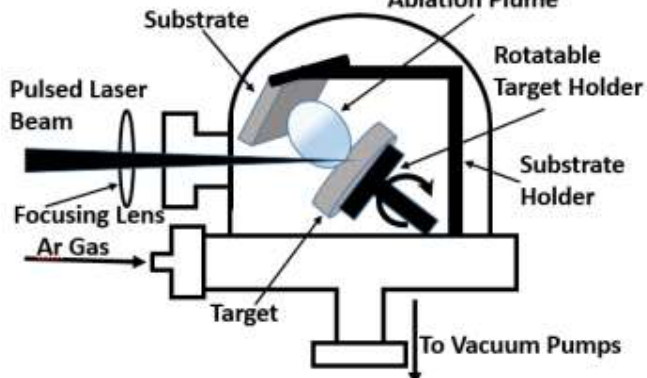
Figure 1: PLA Setup diagram with ZnO target during deposition on the glass substrate .